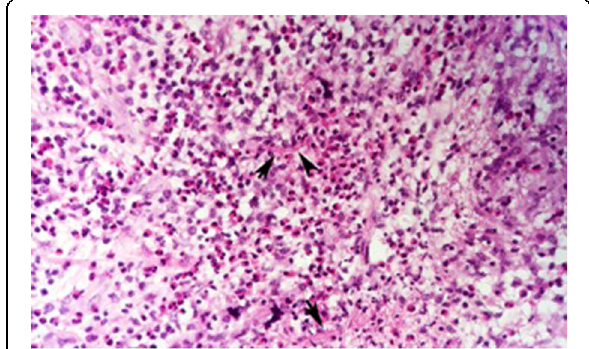
Fig. 5 Orbital mucormycosis. Granulomatous inflammation of orbital soft tissue with infiltration of many eosinophils. Note the presence of hyphea (arrows) in the background. Hematoxylin and Eosin × 400